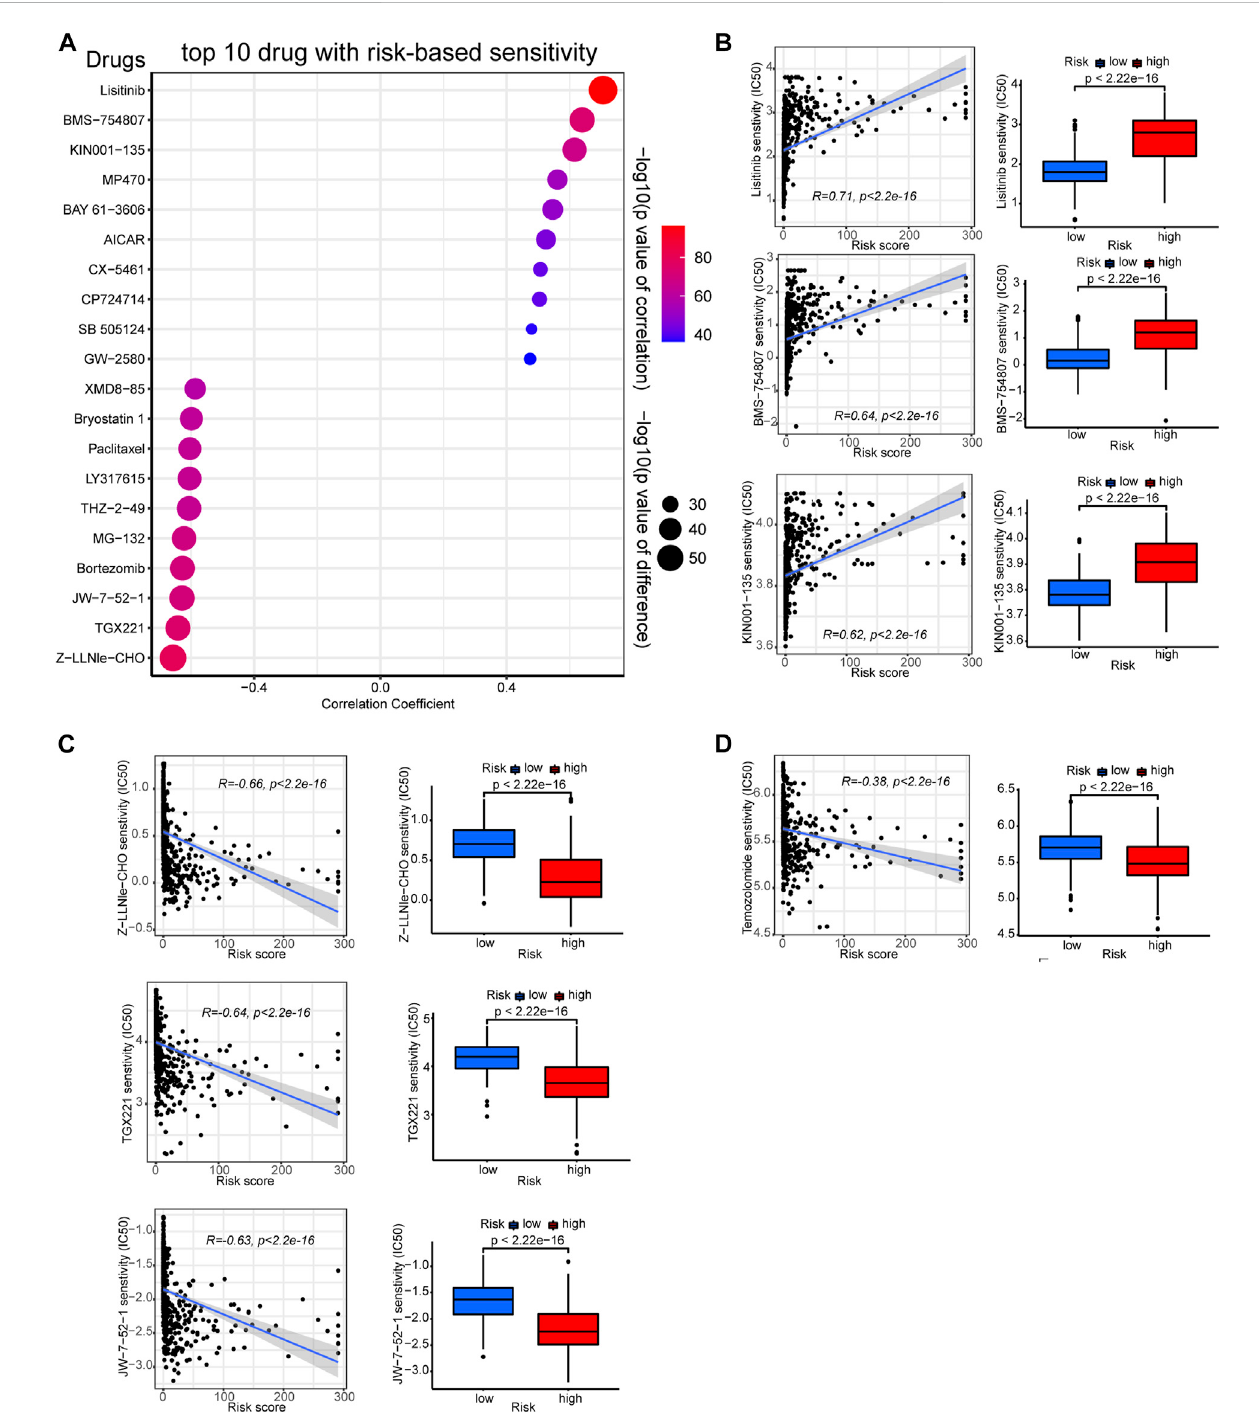
FIGURE 8 Correlation between thePREsriskscore and chemotherapysensitivity ofgliomas. (A) Bubble plot displaying thetop tendrugs with sensitivity preference to high- or low-risk group glioma samples, respectively. Correlation scatter plots and sensitivity difference box plots of drugs that are more effective to low- risk (B) or high-risk (C) glioma samples. Correlation scatter plots and sensitivity difference box plots of temozolomide (D)